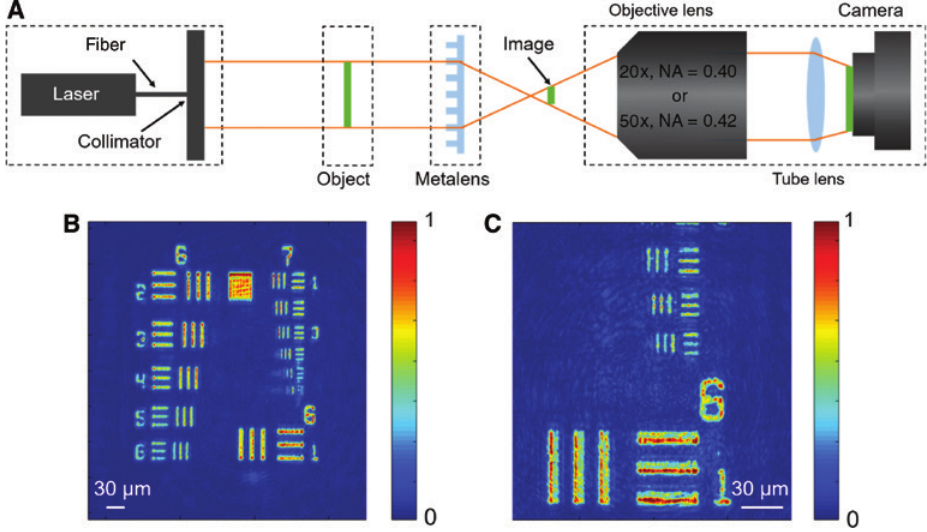
Figure 4: Metalens imaging system setup and results. (A) Schematic of the imaging system setup, including the metalens. Image of the 1951 USAF resolution chart with (B) 14.7 × and (C) 33.8 ×